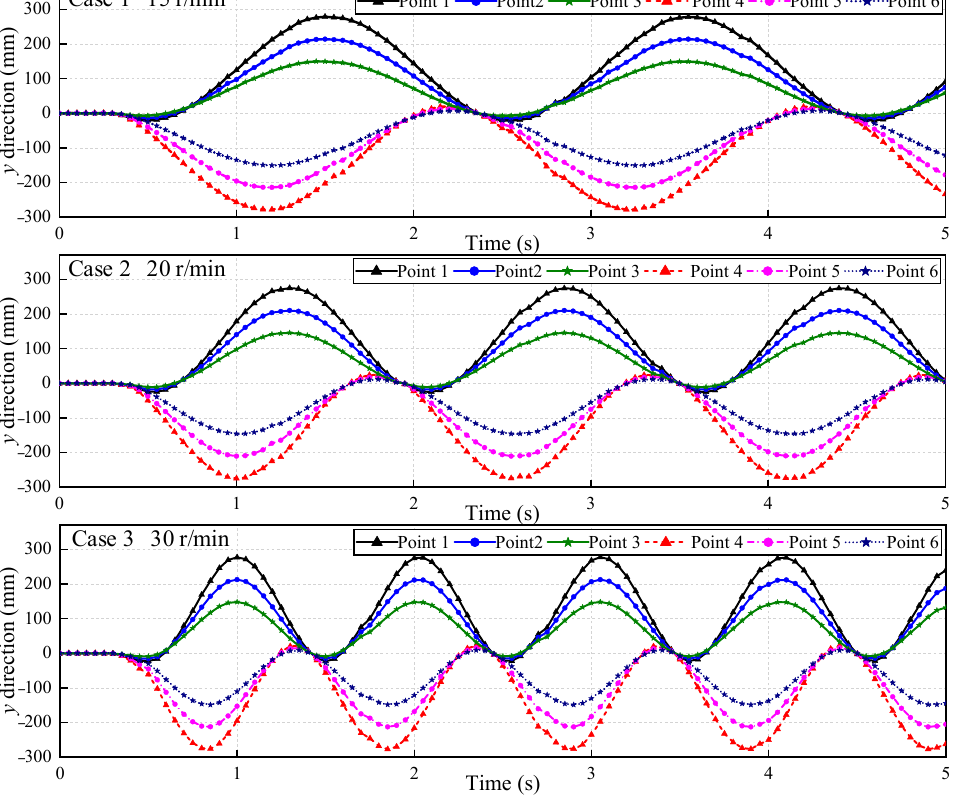
Figure 11. Dynamic displacement of measured points.